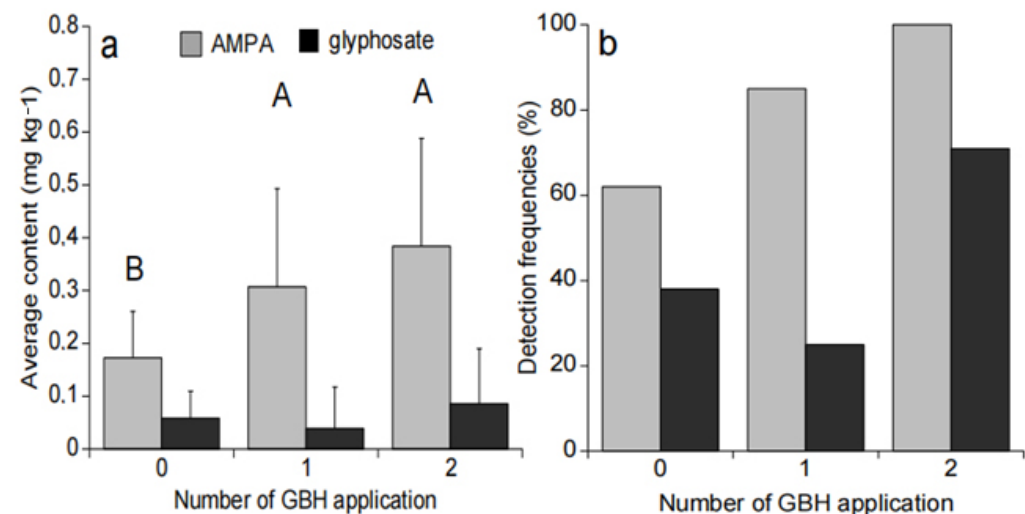
Figure 3. Average glyphosate and AMPA content and associated standard deviation ( a ). Glyphosate and AMPA detection frequencies in soils ( b ) at harvest time according to the number of GBH applications. The letters A and B represent the different significant groups.